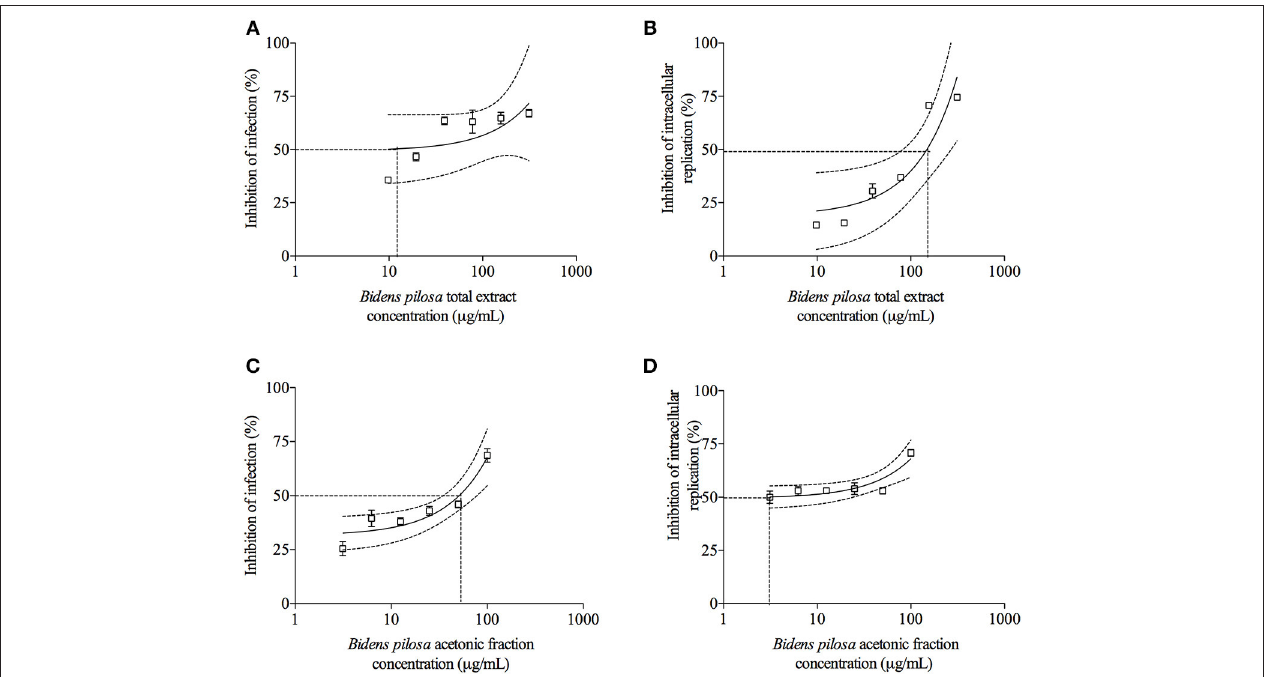
FIGURE 4 | Effects of treatment with total extract or acetonic fraction of Bidens pilosa on Toxoplasma gondii infection index and intracellular replication in HeLa cells. Treatments were carried out on T. gondii tachyzoites before infection of HeLa cells with total extract (A,B) or acetonic fraction (C,D) . Results are expressed as inhibition of percentage of infection (A,C) and parasite intracellular replication (B,D) in comparison to controls. Dotted lines show the inhibitory concentration of 50% (IC 50 ) and bars represent standard deviations. Values are representative from three independent experiments, indicating mean ±